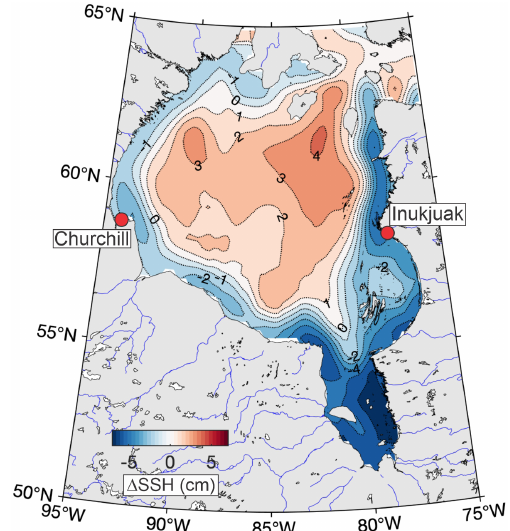
Figure 10. The long-term mean (1993–2020) difference between sea surface height (SSH; cm) in summer (June–August) and fall (September–November) derived from the satellite altimetry. Red dots depict the tide gauge in Churchill and